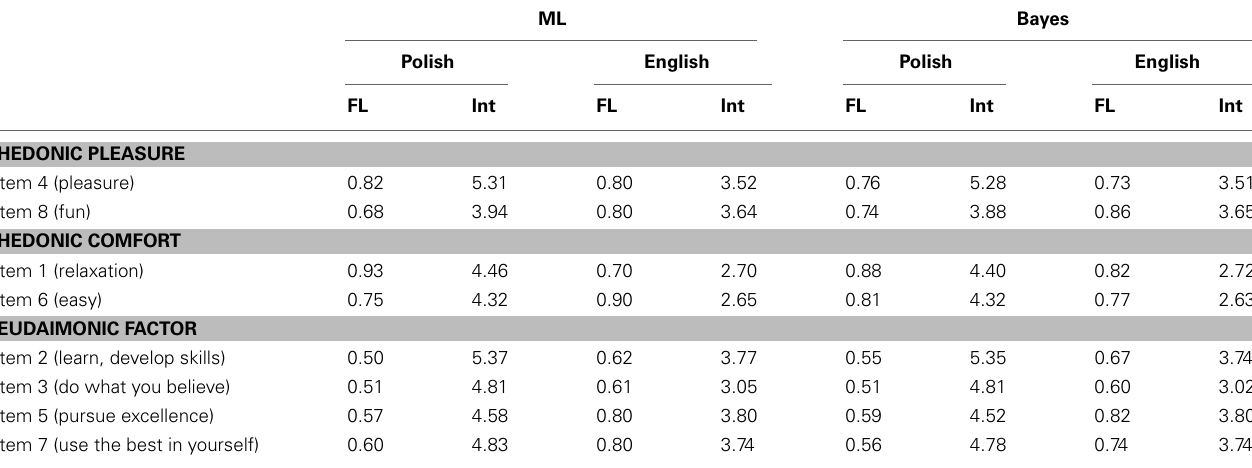
Table 5 | Standardized factor loadings and intercepts for the metric invariance model.